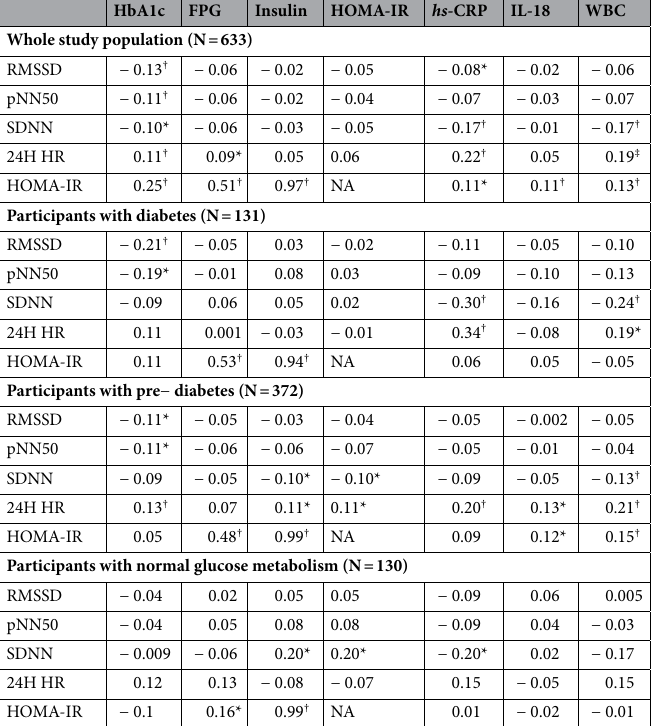
Table 2. Measures of heart rate, heart rate variability, glycated hemoglobin (HbA1c), insulins resistance (HOMA-IR) and different inflammation markers of interest and their association. Results are presented as correlation coefficient (r). hs-CRP High sensitivity C-reactive protein, IL18 Interleukin-18, WBC White blood cell count, FPG Fasting plasma glucose, HOMA-IR Homeostatic model assessment for insulin resistance, SDNN Standard deviation of normal-normal complexes, RMSSD Root mean square of successive normal- normal interval differences, pNN50 proportion of NN intervals which differs by more than 50 ms, 24H HR 24-h heart rate. Derived from MEAN NN : MEAN NN /60.000 = Average HR. *p < 0.05. † p <